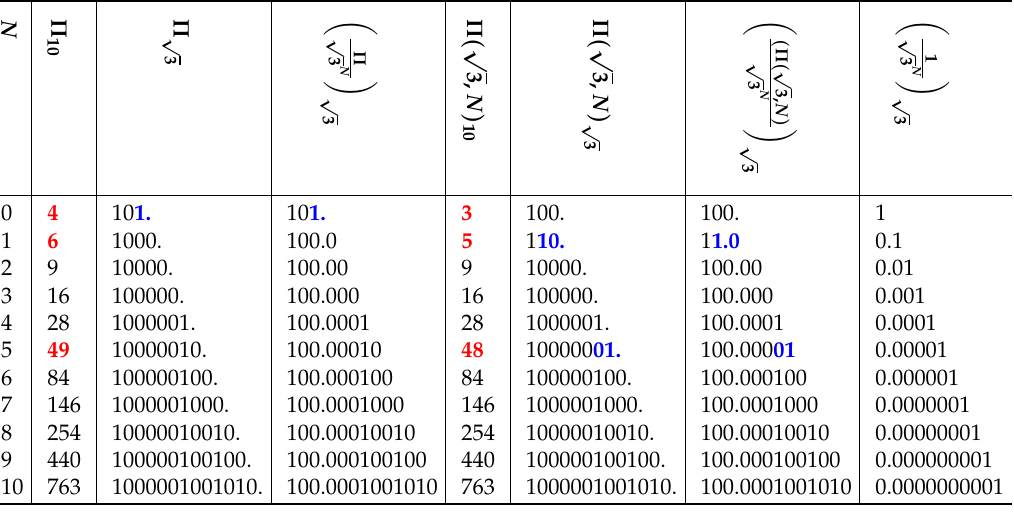
√ √ Table 5. Number of collisions Π ( 3, N ) given by (13) and (14) and approximation of π for b = 3. √ The first column is N . The second column is Π ( 3, N ) calculated by (13) in the decimal base. The √ third column is the integer part of the number of collisions Π ( 3, N ) given by (13) and written in √ √ the base 3. The fourth column is the number π with N digits in the fractional part in the base 3 √ calculated by (14) . The fifth column is Π ( 3, N ) given by (14) in the decimal base. The sixth column √ √ is the integer part of the number of collisions Π ( 3, N ) given by (14) and written in the base 3. The seventh column is the number π calculated by (14) with N digits in the fractional part in the √ base 3. The eighth column gives the systematic error according to Equation (55). The cases where approximation (14) fails as compared to (13) are highlighted by red. The blue color stands for the digits which are incorrectly predicted by the Galperin billiard.